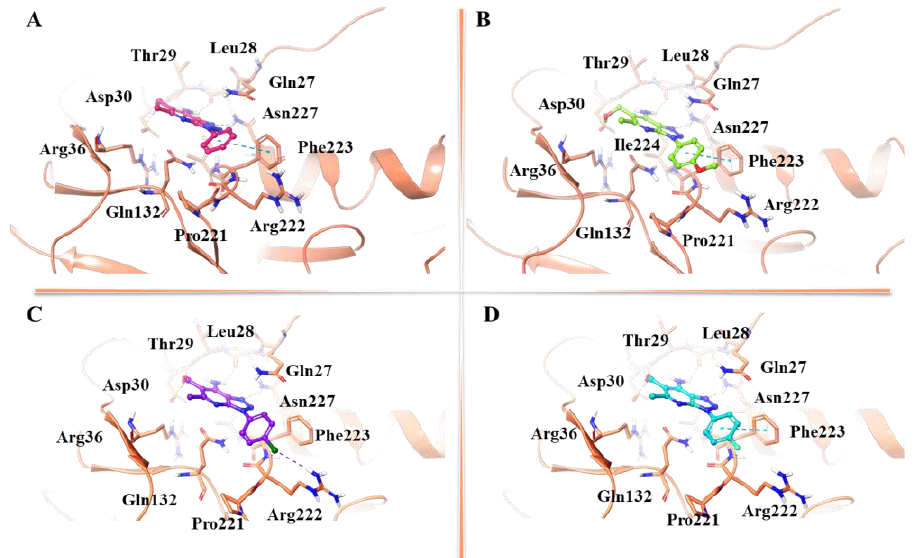
Figure 7. 3D representation of ( A ) 14 , ( B ) 16 , ( C ) 83 , and ( D ) 85 in complex to the most populated cluster of gD-Pocket 2. gD-Pocket 2 is illustrated in salmon, with the residues involved in pivotal contacts shown as carbon sticks. Compounds 14 , 16 , 83 , and 85 are depicted as pink, green, violet, and cyan carbon sticks, whereas H-bonds and π - π interactions are indicated as yellow and cyan dashed lines,